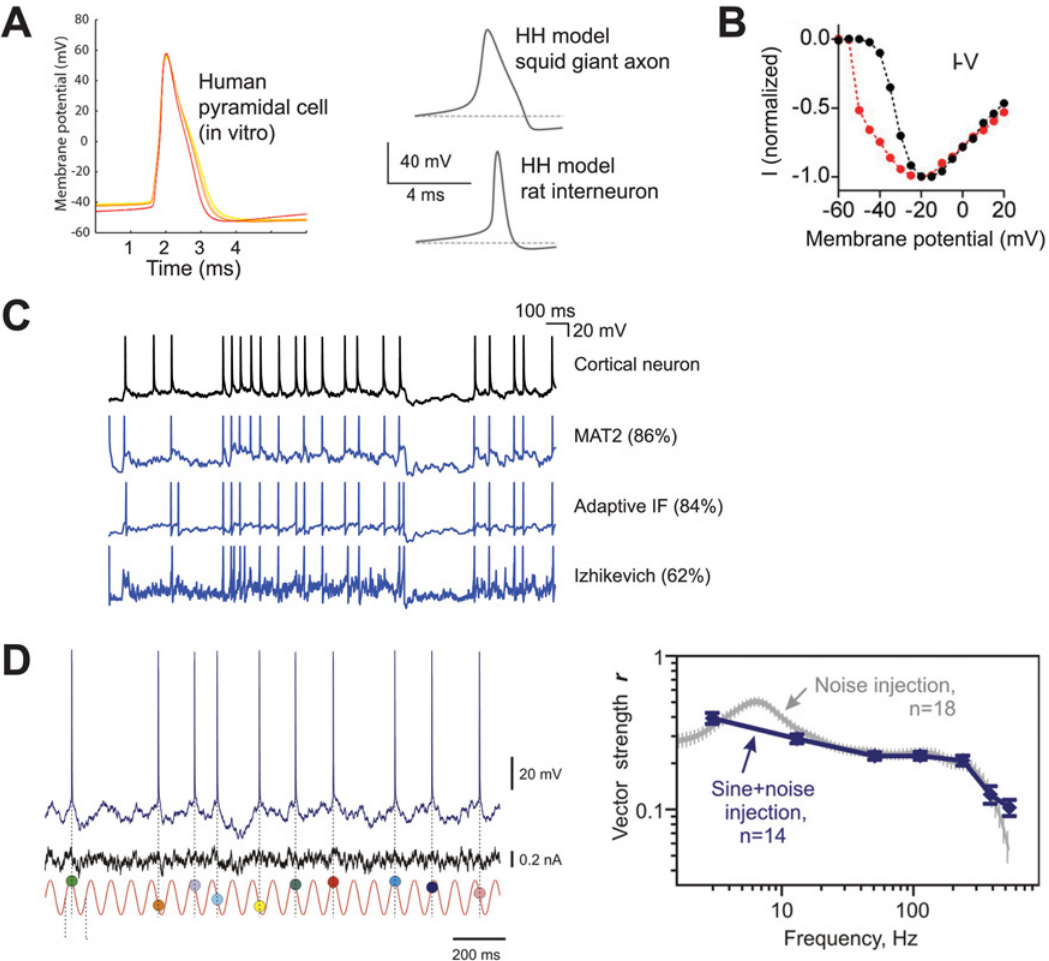
Fig 3. Empirical accuracy of the single-compartment HH model. (A) Spikes of real neurons have a distinct kink at onset (top: human pyramidal cell, adapted from [18]), which does not appear in single-compartment HH models (bottom: HH models of squid giant axon and rat hippocampal interneuron, adapted from [19]). (B) The peak current in somatic voltage-clamp shows a discontinuity as a function of voltage (red), not seen when axonal Na channels are inactivated (black) (adapted from [20]). (C) Spiking responses of cortical neurons in vitro to somatic current injection (black) are well predicted by integrate- and-fire models with sharp spike initiation (blue, first two traces; percentages are proportion of correctly predicted spikes) but not by the Izhikevich model, a variation of the quadratic model (blue, third trace) (adapted from [22]). (D) Phase locking to high frequencies: cortical neurons fire at preferred phases of a sinusoidal current added on top of noise (left), at frequencies up to several hundred Hz (right, vector strength is a measure of phase locking) (adapted from [23]).